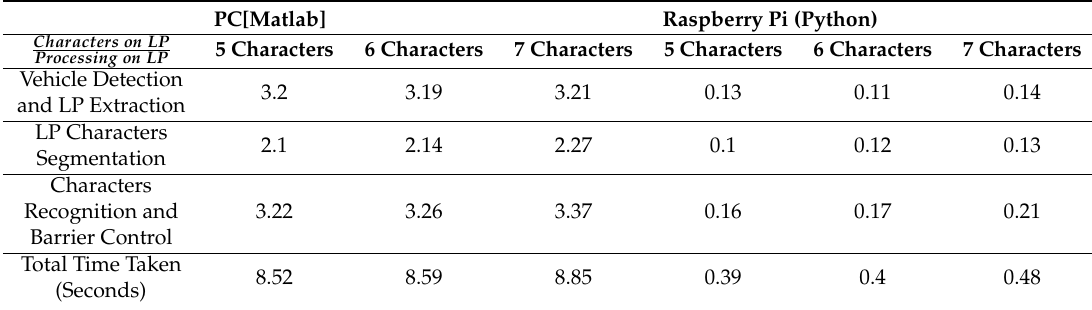
Table 6. Performance comparison of time (Seconds) taken by the proposed system implemented on a PC (running Matlab) and a Raspberry Pi (Python +